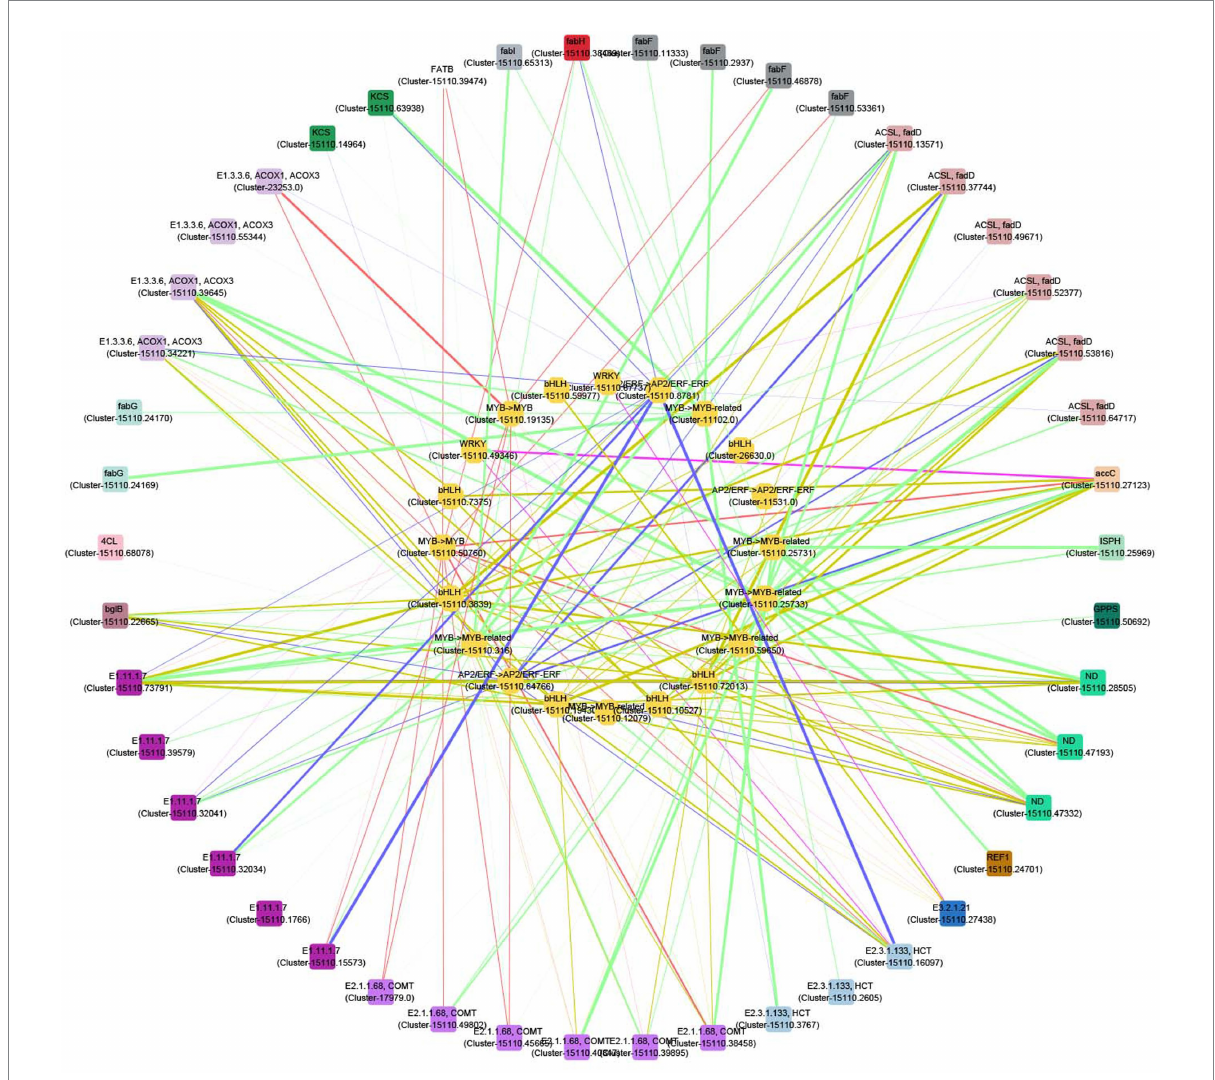
FIGURE 7 Correlation network between transcription factors (TFs) and structural genes in the biosynthesis of terpenes, phenylpropanoids, unsaturated fatty acids, and fatty acids. Outer circle: structural genes; inner circle: TFs; color of nodes: gene types; width of edges: correlation coefficient